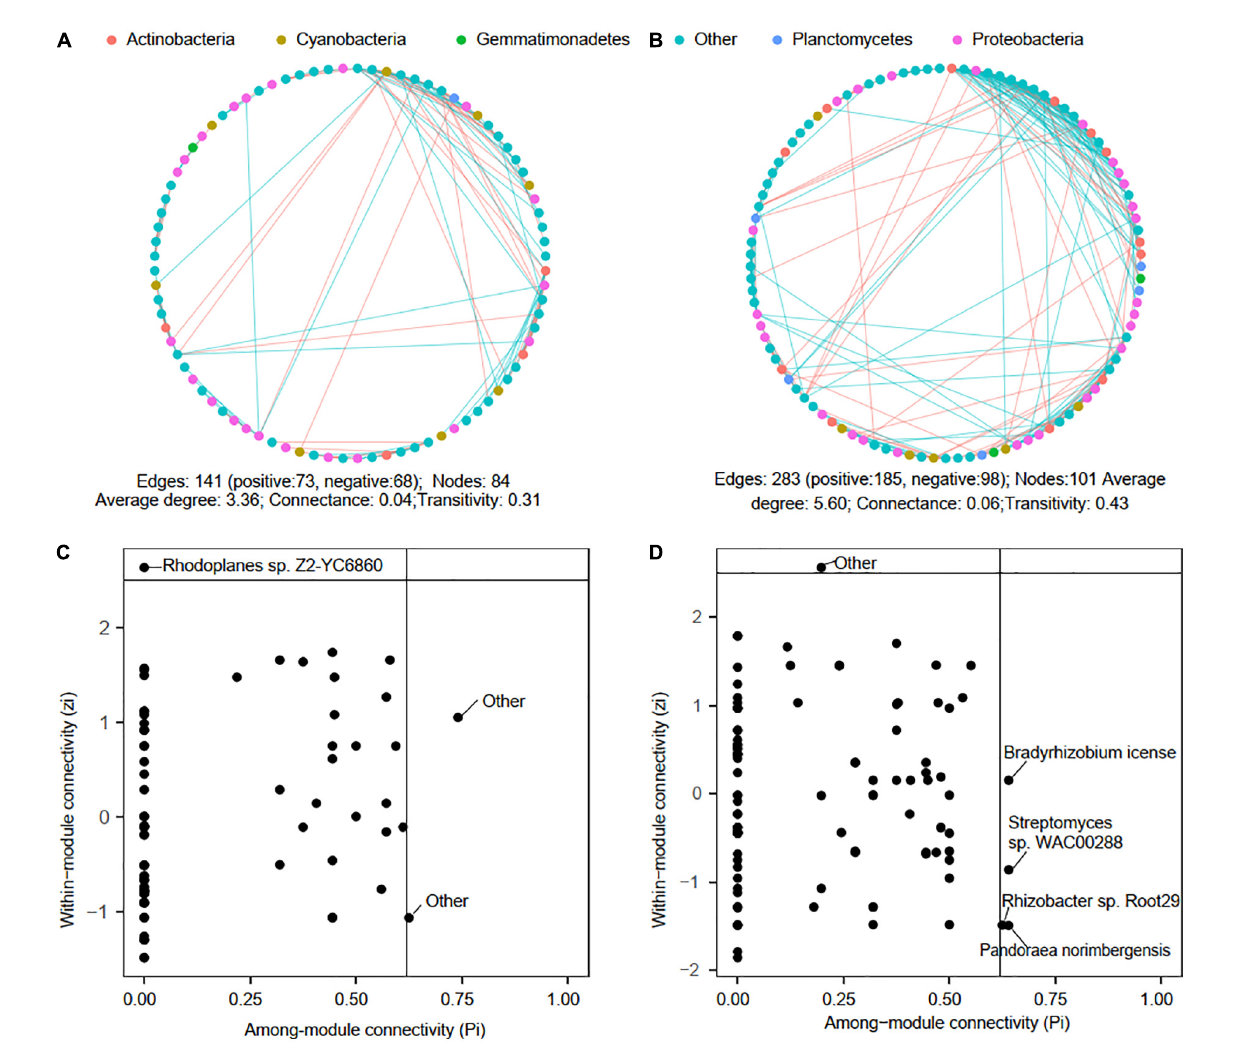
FIGURE5 Overview of the reconstructed microbial co-occurrence networks in low-P (P0 ∼ P30) and high-P (P40 ∼ P60) treatments. Panels (A,B) visualized microbial co-occurrence networks in low-P and high-P treatments, respectively ( n = 12 for low-P network and n = 9 for high-P network). The node color corresponds to microbial phylum. The edges in cyan represent positive correlation of two ASVs, and edges in red represent negative correlation of two ASVs. Panels (C,D) ZP-plot in the networks of low-P and high-P treatments, respectively. The taxonomy of each module hub (Zi ≥ 2.5, Pi < 0.62) and connector (Zi < 2.5, Pi ≥ 0.62) at species level was